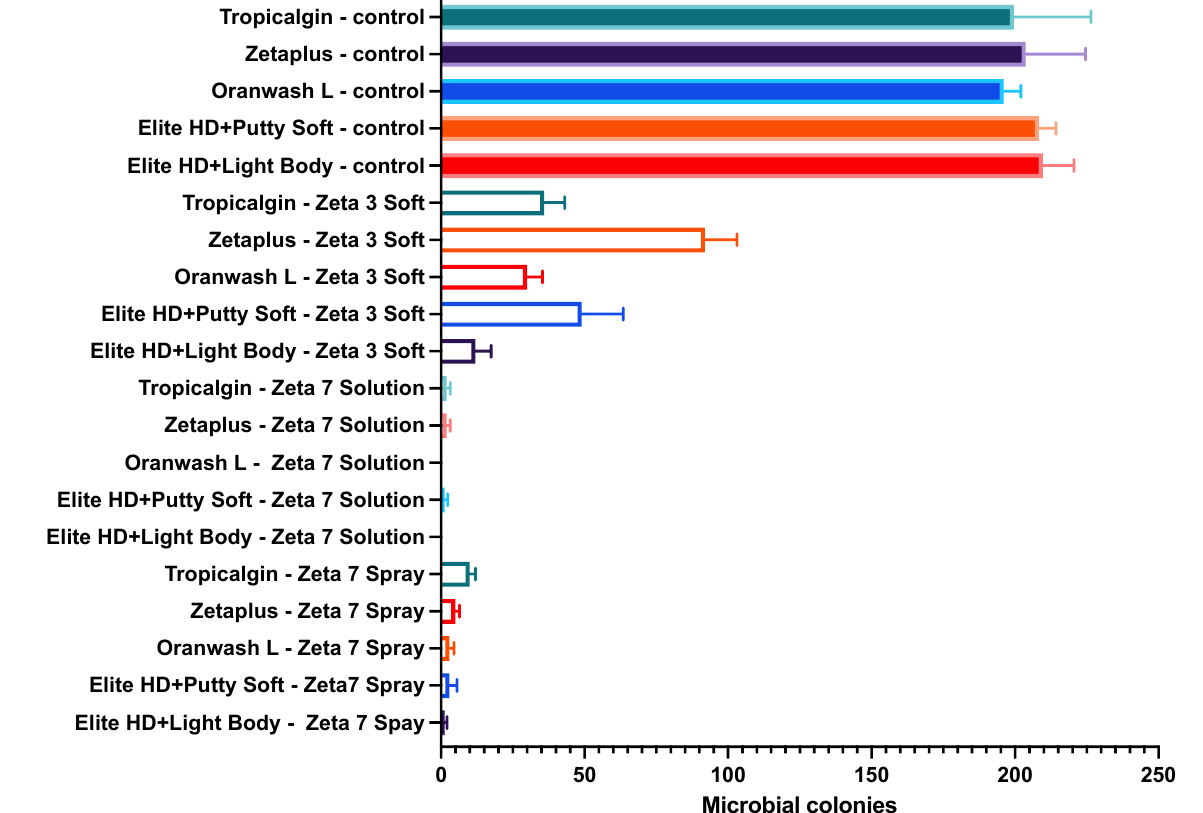
Figure 6. The number of microbial colonies for all impression materials before and after disinfection.